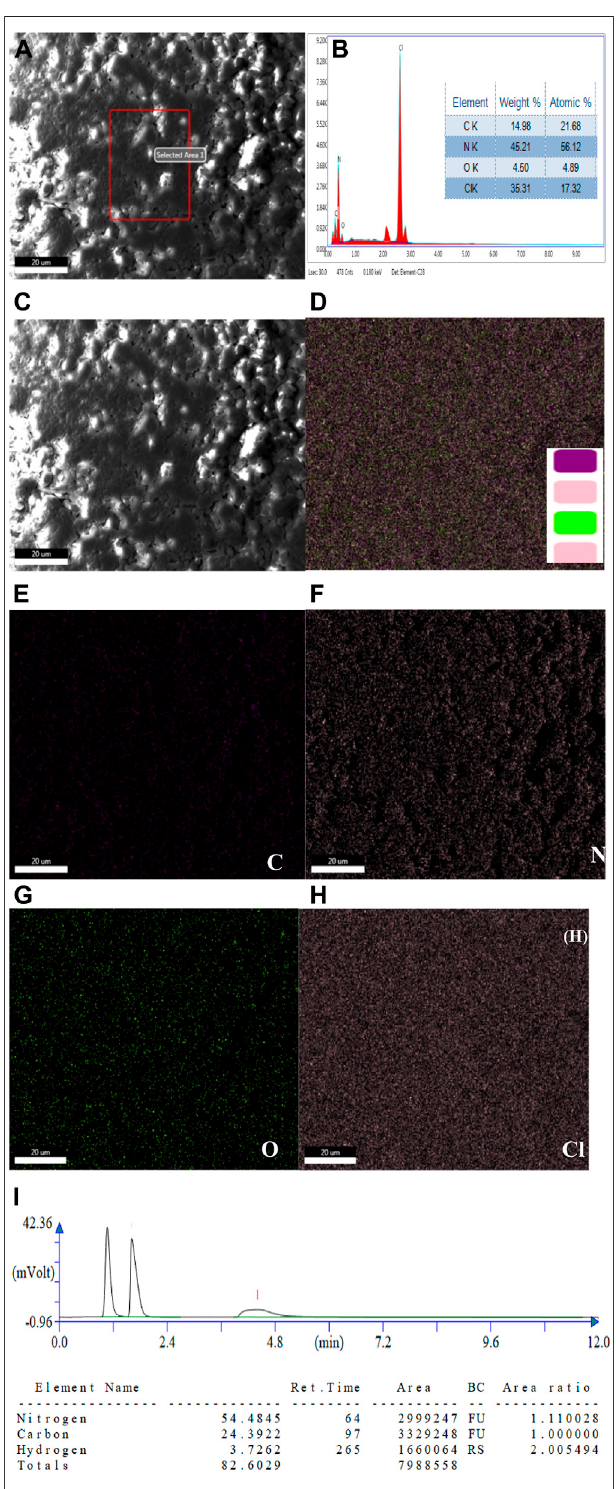
FIGURE 2 | (A) FESEM image of Cl-CNDs with selected area for collecting the elements present (B) corresponding EDX spectrum along with